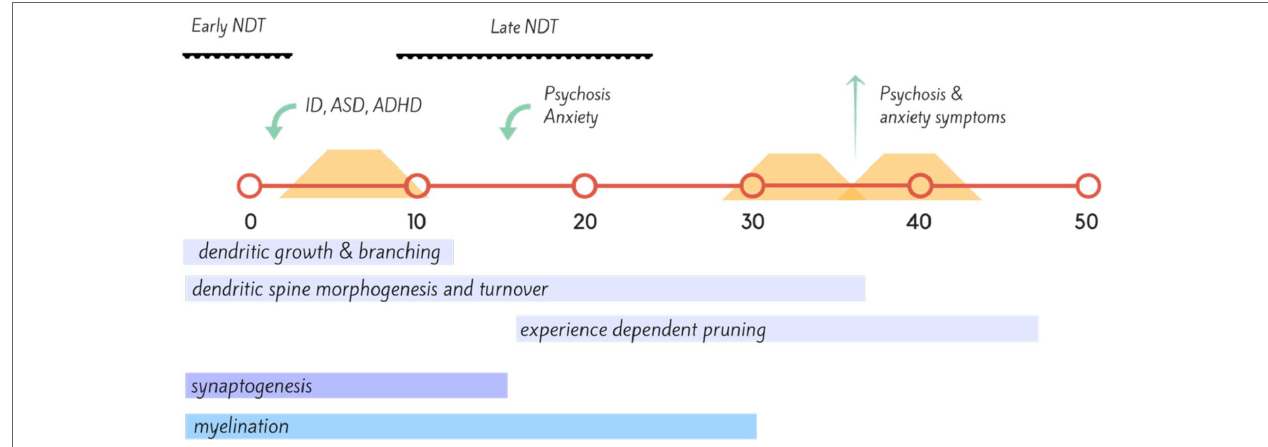
FIGURE 2 | Timeline (in years) of proposed neural development, onset of neuropsychiatric disorder (green) and dietary coverage (orange) for Case Vignette 1. This case highlights the importance of neuronal development across the lifespan, with insult during the early neurodevelopmental (NDT) stages resulting in intellectual disability (ID), autism spectrum disorder (ASD), and attention deficit hyperactivity disorder (ADHD); while insult during the later stages of neurodevelopment, during adolescence with disruption of synaptic pruning leading to disorders such as bipolar disorder and in this instance, schizophrenia (159,